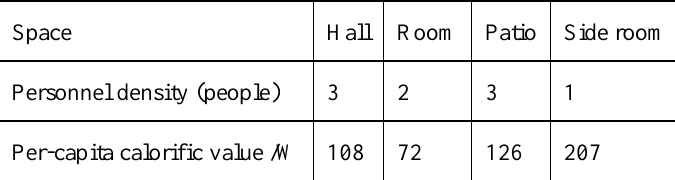
Table 5. The personnel density and per-capita calorific values